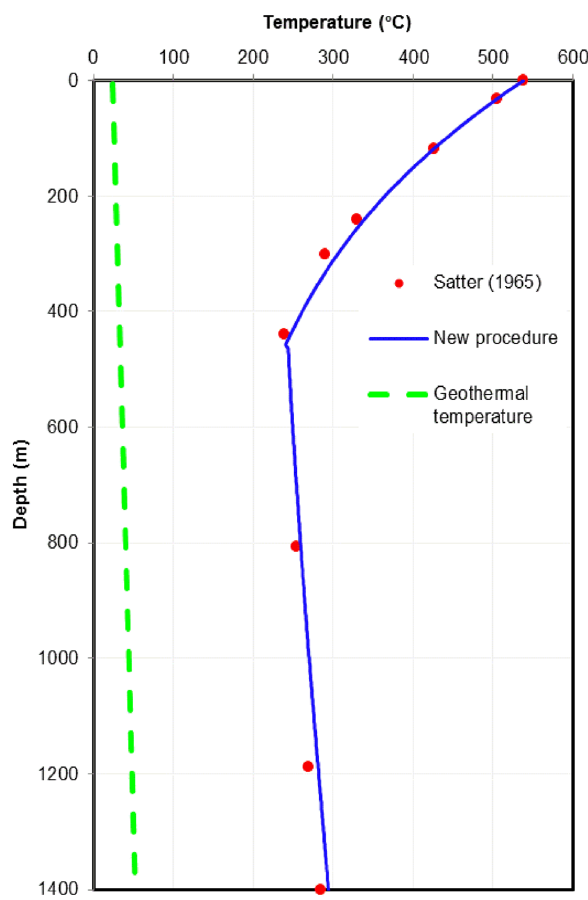
Fig. 8 Comparison of temperature distribution with well depth